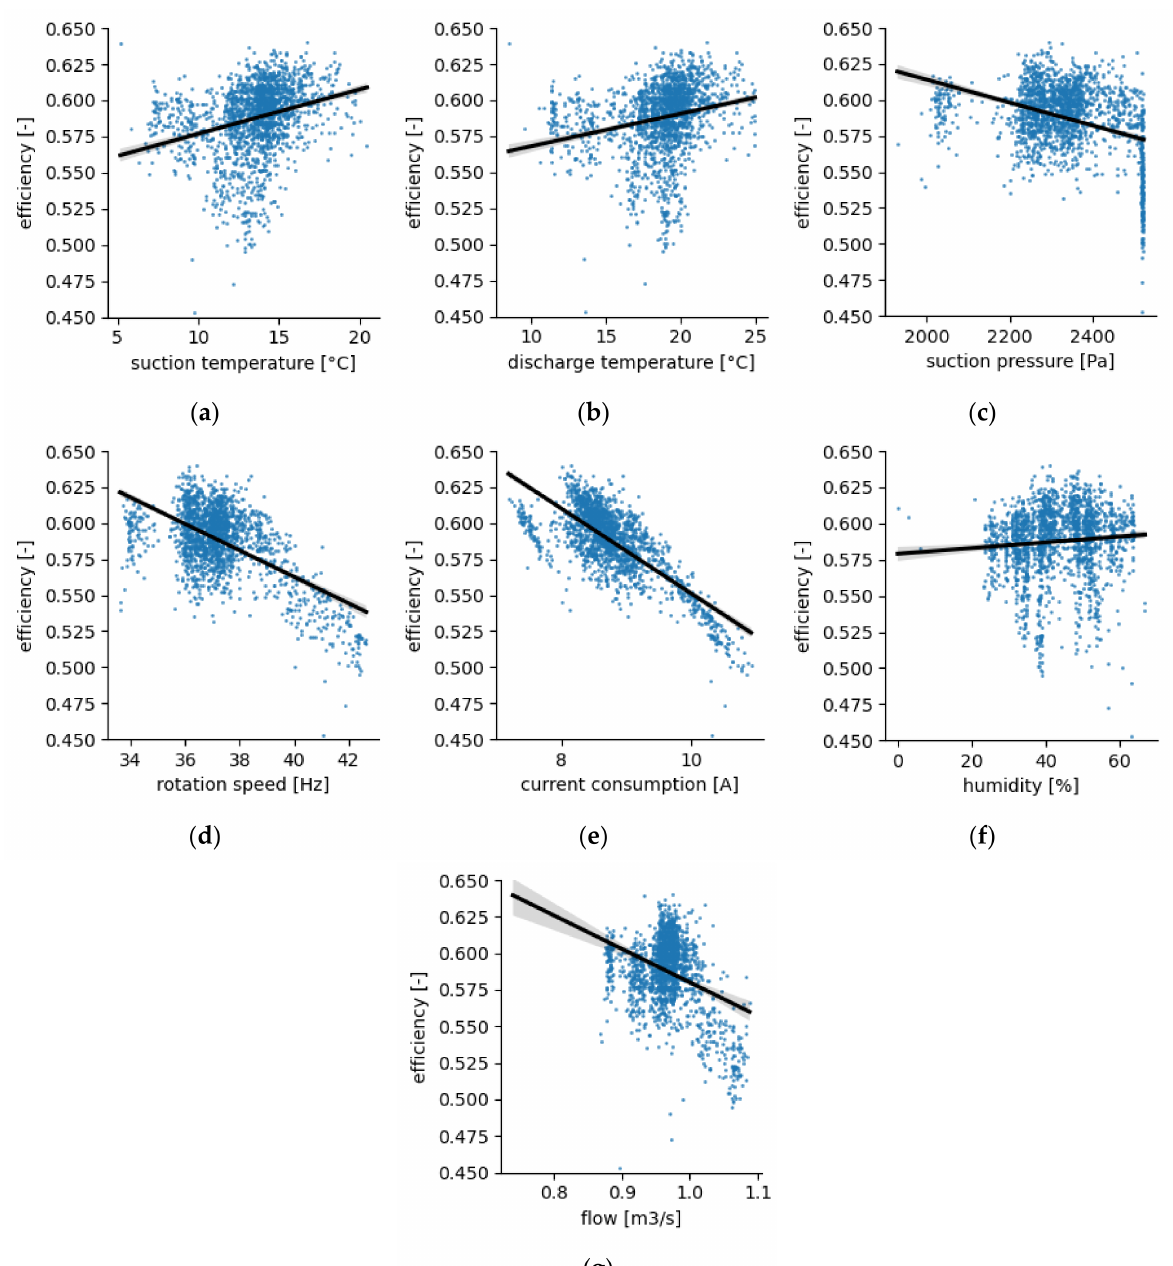
Figure 4. The dependence of the fan efficiency on the measured parameters, where: ( a ) suction temperature ( ◦ C), ( b ) discharge temperature ( ◦ C), ( c ) suction pressure (Pa), ( d ) rotational speed (Hz), ( e ) current consumption (A), ( f ) humidity (%), ( g ) flow(m 3